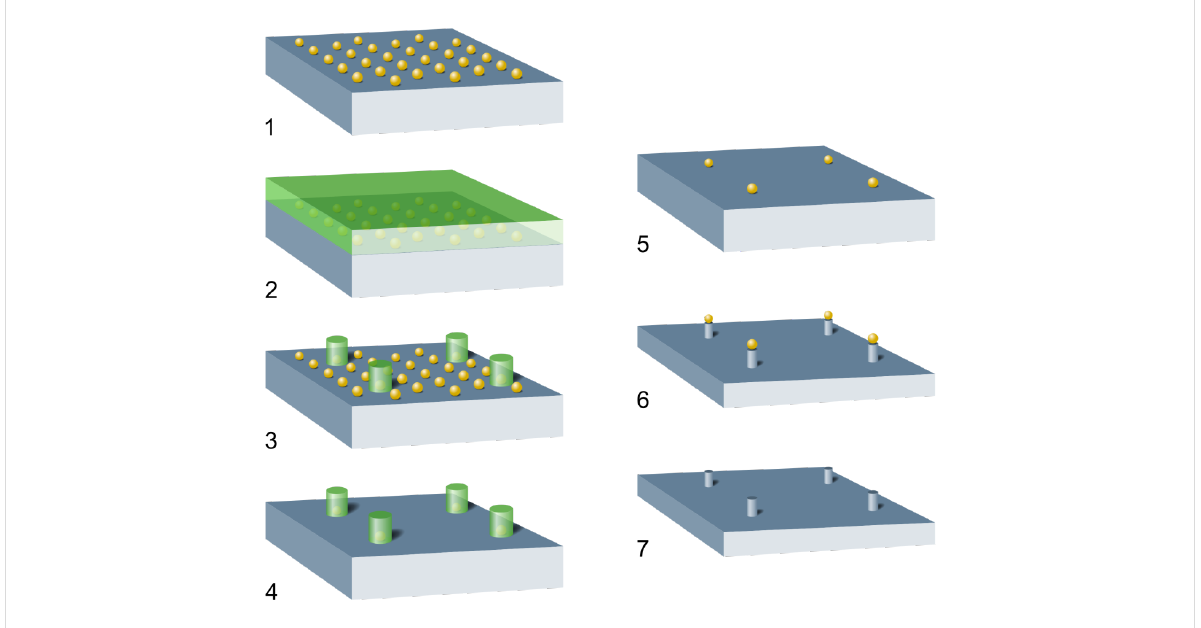
Figure 2: Schematics of the process leading to positioning nanoparticles on the micrometer scale: (1) Start; nanoparticles (NP) prepared by applying a method based on the self-organization of precursor loaded micelles on top of a flat substrate; here Au NP on Si; (2) Spin-coated negative resist for electron-beam lithography (EBL); (3) Resist disks arranged in a square lattice as obtained after EBL; (4) Removal of the residual Au NP between the disks by I/KI solution; (5) Stripping of the resist delivers the final NP arrangement; (6) Optional; using the NP as masks for a subsequent RIE etching step resulting in correspondingly arranged nanopillars; (7) Optional; removing the residual NP masks.